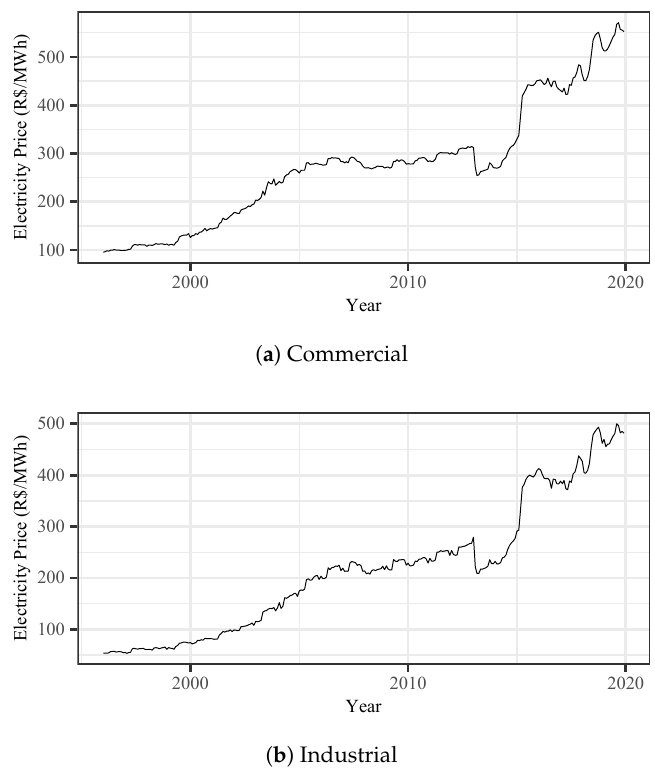
Figure 1. Brazilian electricity